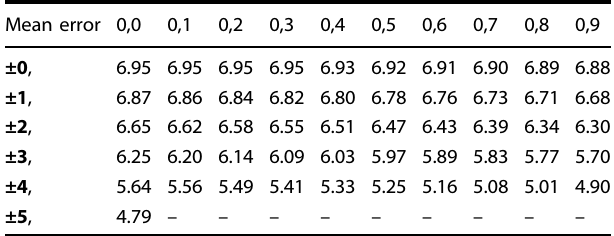
Table 6. ISO Criterion 2 — Maximum permissible standard deviation as function of the error